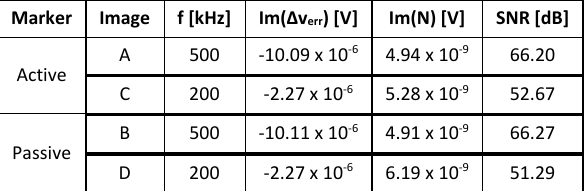
Table 1: Some quantitative data on the erroneous signals